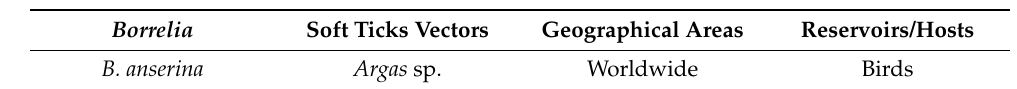
Table 5. Avian relapsing fever Borreliae .